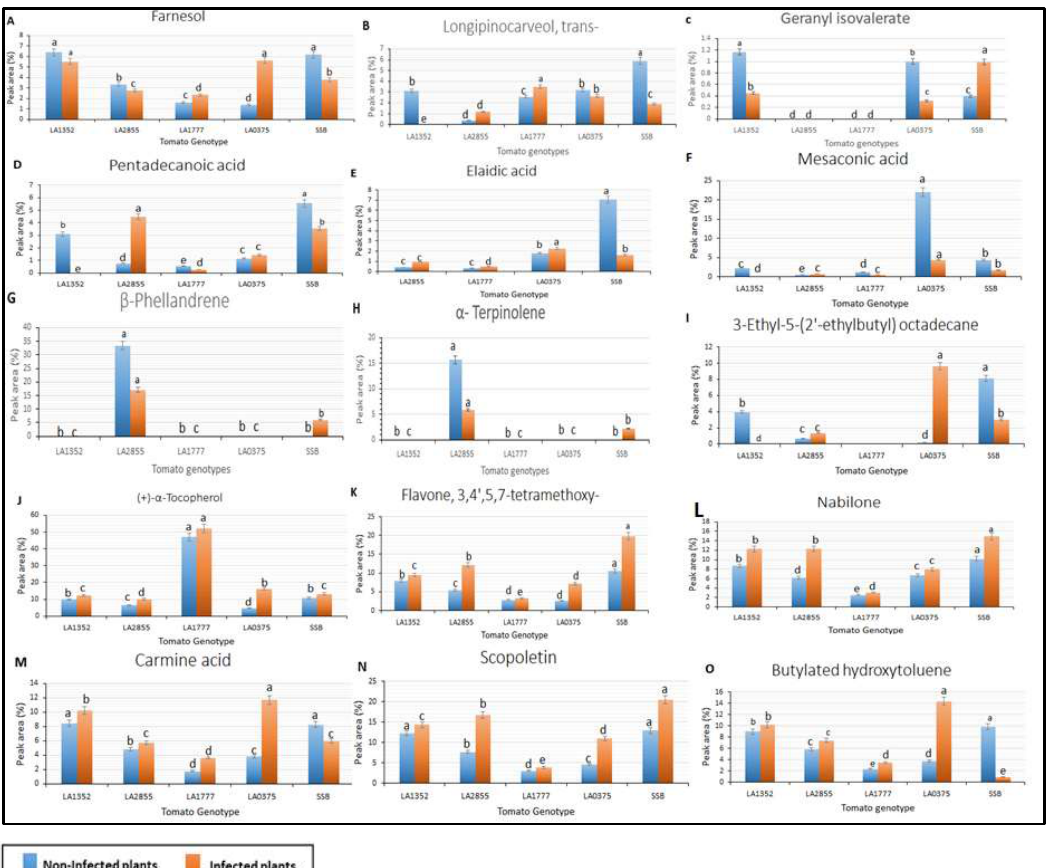
Figure 4. Volatile organic compounds were detected in both resistant and susceptible tested tomato genotypes with fluctuation of peak area percentages of infected and non-infected plants using Gas chromatography/mass spectrometry. SSB—Super Stain B. The blue bar indicates the control group that was not inoculated (non-infected plants); the orange bar indicates the inoculated group (infected plants). Each compound is presented in a bar chart: ( A ) Farnesol ( B ) Longipinocarveol, trans- ( C ) Geranyl isovalerate ( D ) Pentadecanoic acid ( E ) Elaidic acid ( F ) Mesaconic acid ( G ) β-Phellandrene ( H ) α-Terpinolene ( I ) 3-Ethyl-5-(2’-ethylbutyl) octadecane ( J ) (+)-α-Tocopherol ( K ) Flavone, 3,4’,5,7-tetramethoxy- ( L ) Nabilone ( M ) Carmine acid ( N ) Scopoletin ( O ) Butylated hydroxytoluene. Results are given as mean values ± standard deviations. Values in the same bar chart with different letters are significantly different at p < 0.05.